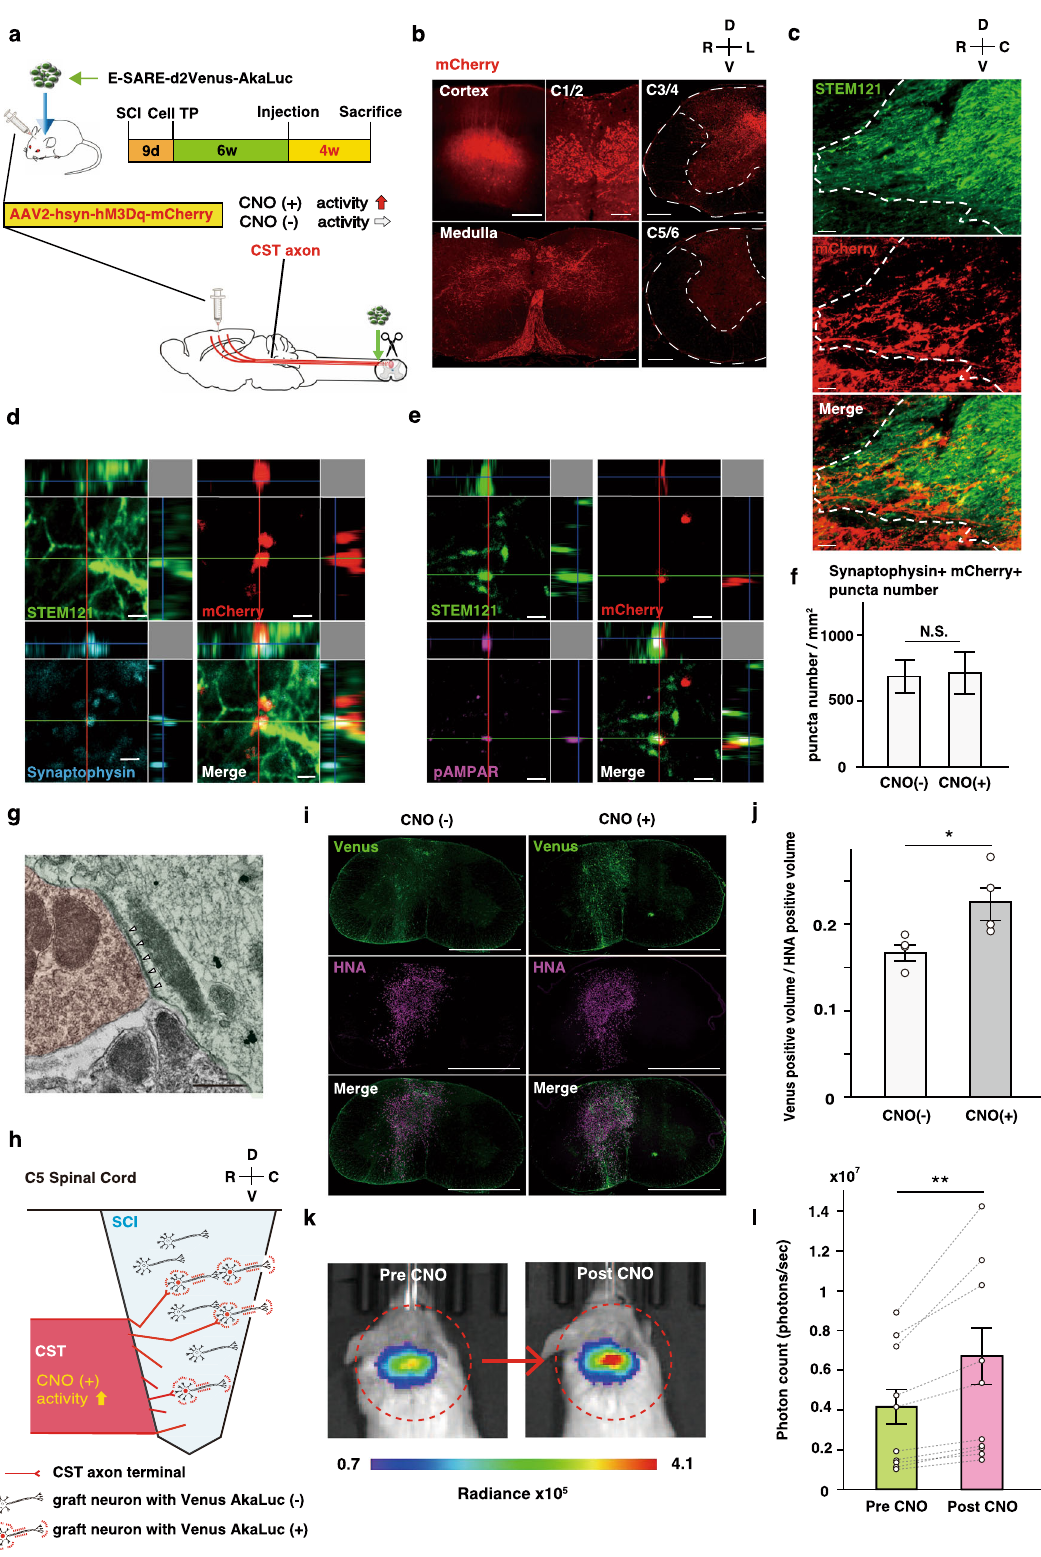
In vitro neuronal differentiation . Mouse astrocyte-feeder cells, which had been extracted from the E17 mouse cerebral cortex, were plated on 24-well chamber glass slides coated with poly-D-lysine (Sigma – Aldrich). The feeder cells were cultured at 37 °C in 5% CO 2 and 95% air for 3 – 7 days (5 × 10 4 cells/well). Qua- ternary neurospheres dissociated using TrypLE Select were plated onto chamber glass slides precoated with the astrocyte-feeder layer at a density of 1×10 5 cells/well. The cells were cultured for 50 days in neuronal maturation medium consisting of